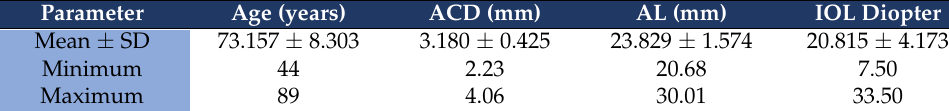
Table 2. Descriptive data of all of eyes included in the study.